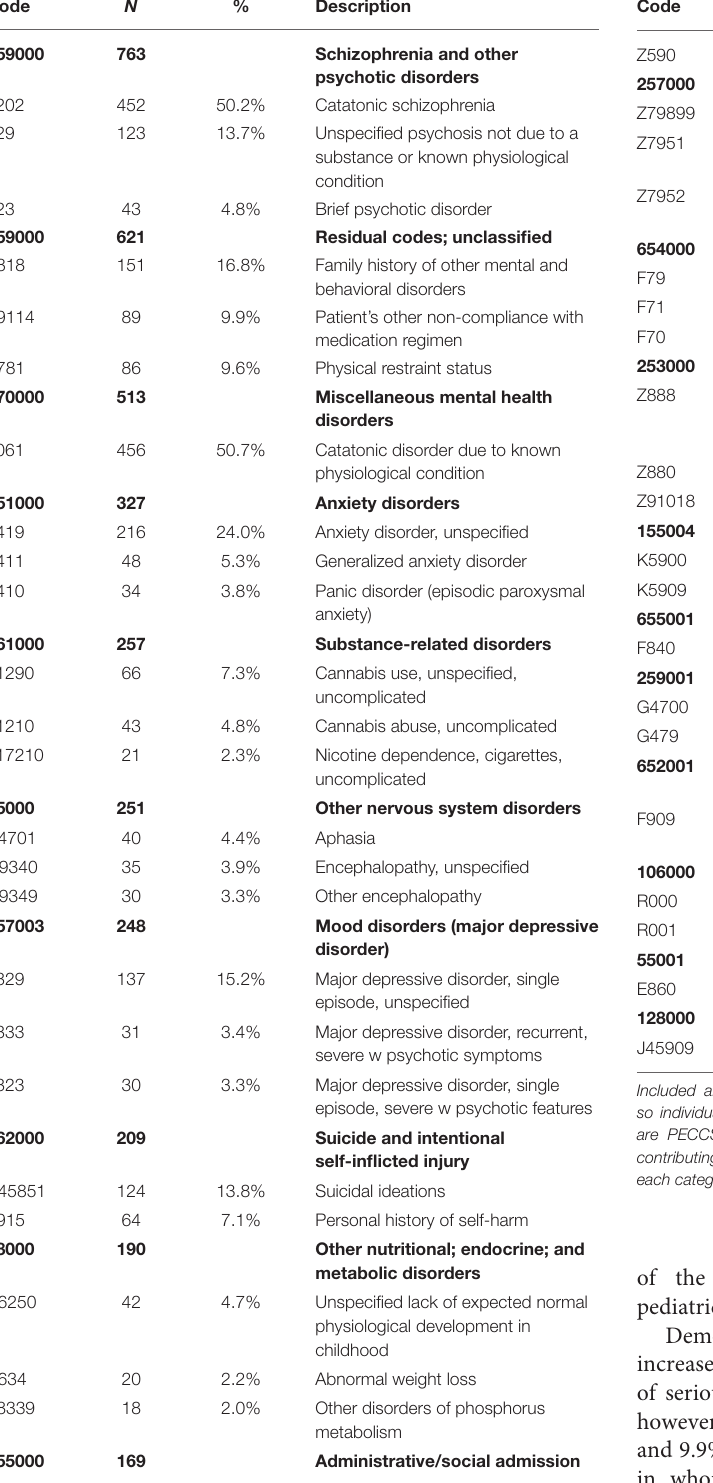
TABLE 3 | Discharge diagnoses for pediatric catatonia